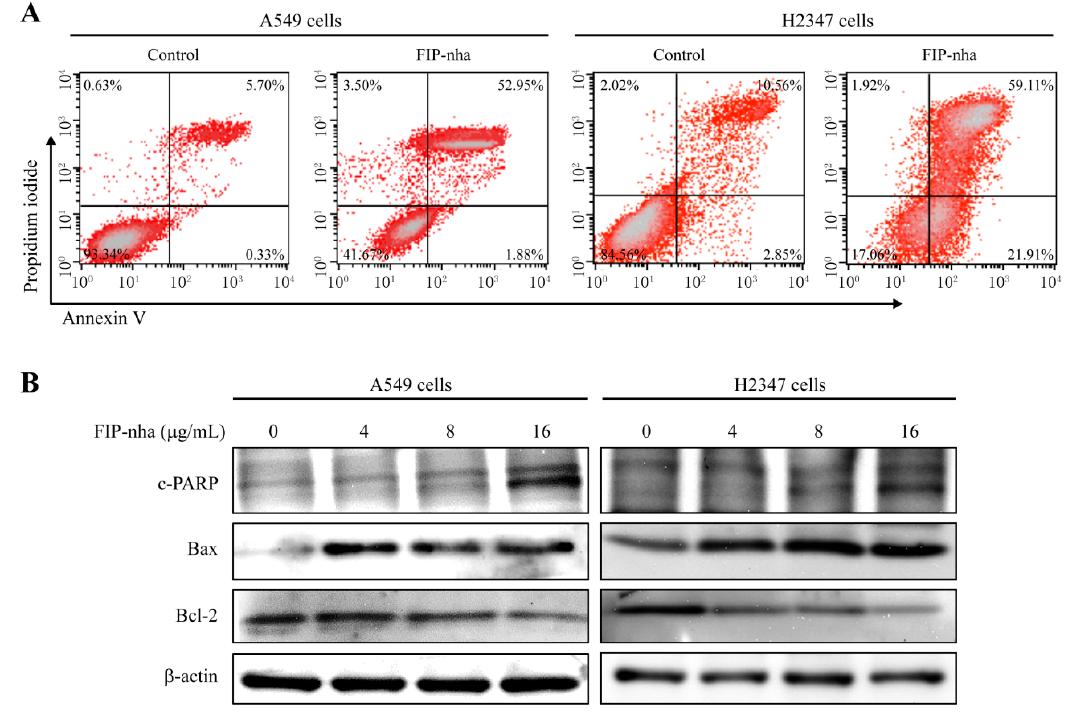
Figure 5. FIP ‐ nha induces apoptosis in A549 and H2347 cells. ( A ) A549 and H2347 cells